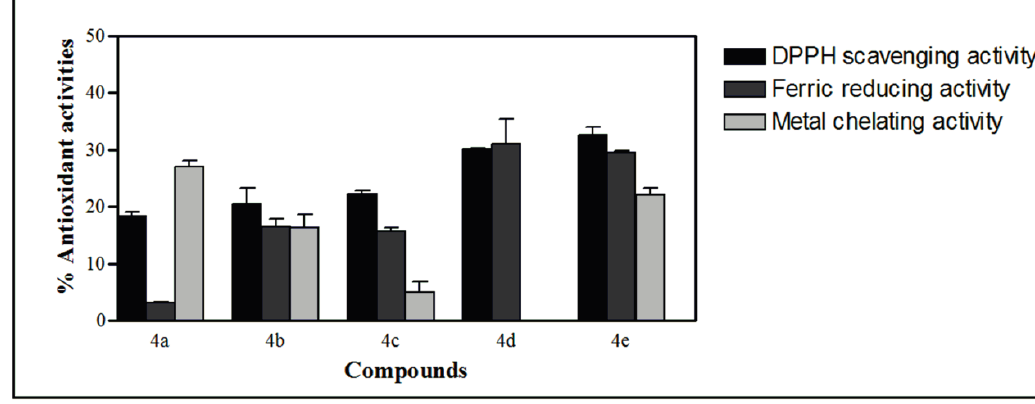
Figure 8. DPPH scavenging, ferric reducing and metal chelating activities of compounds 4 ( a – e ) at final concentration of 2 mg/mL. Each value represents the mean ± SD of triplicate